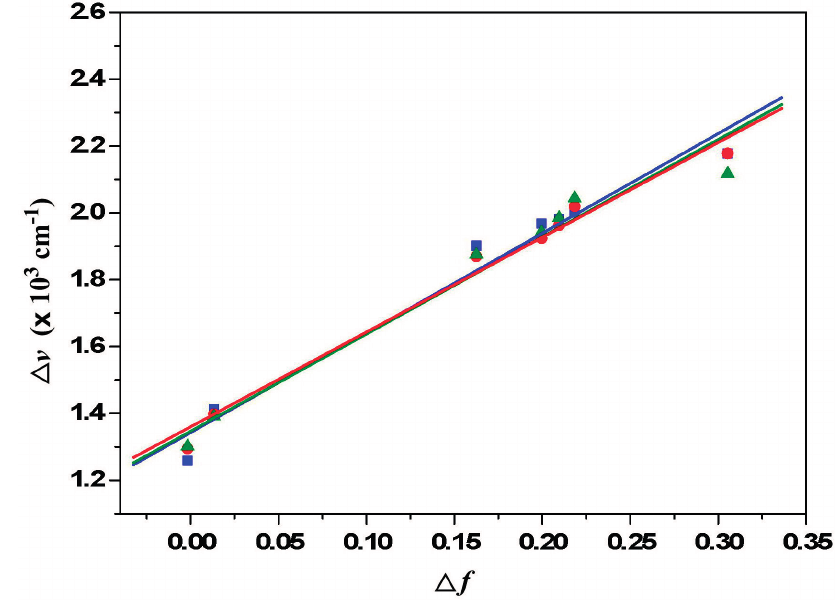
Figure 5. Lippert-Mataga plots for 1a (red line and red symbols), 1b (green line and green symbols) and 1c (blue line and blue symbols). The solvents from left to right are (1) cyclohexane, (2) toluene, (3) diethyl ether, (4) ethyl acetate, (5) tetrahydrofuran, (6) dichloromethane and (7) acetonitrile.